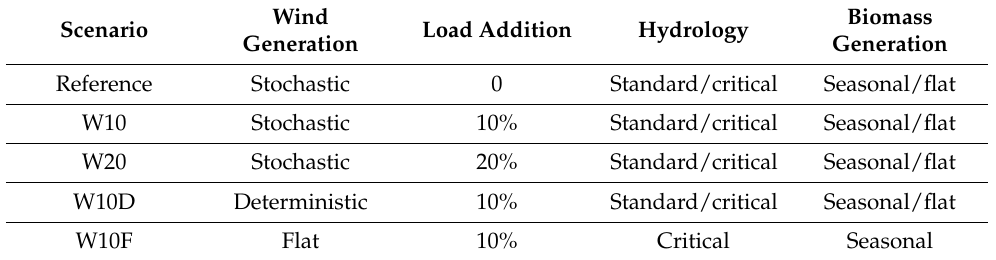
Table 2. Description of main scenario features.